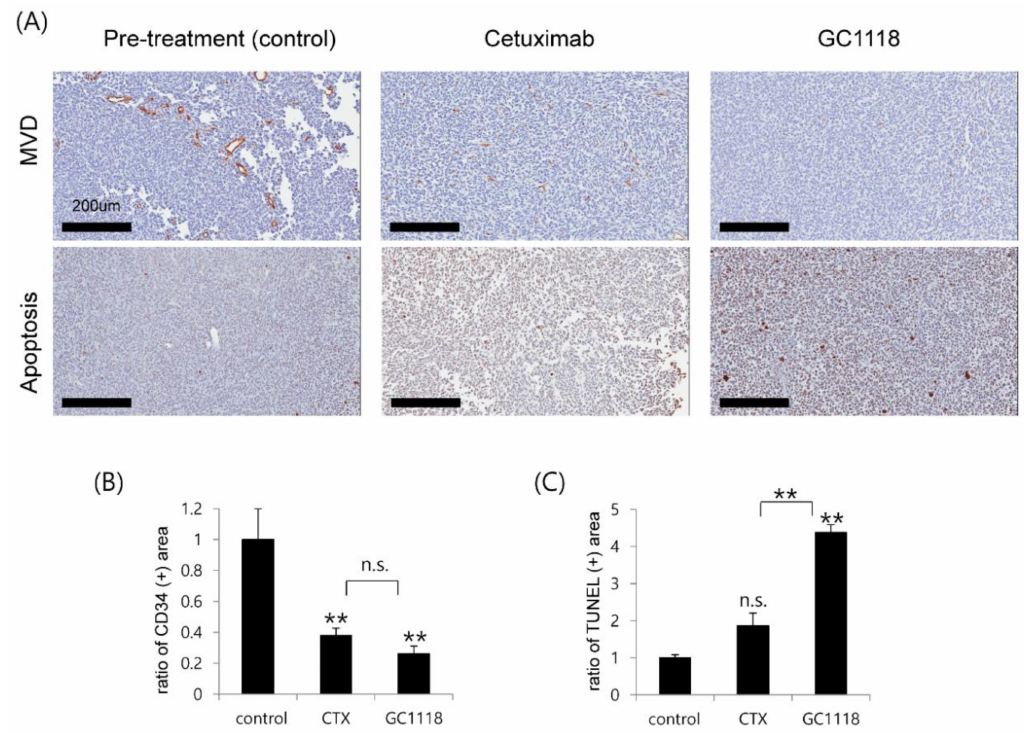
Figure 5. GC1118 exhibited anti-angiogenic e ff ect on GBM tumors and induced apoptosis of GBM tumor cells. ( A ) Representative IHC images of tumor tissue derived from orthotopic PDX models (N626) demonstrated the anti-angiogenic and apoptotic e ff ect of GC1118 treatment. Microvascular density (top row) and apoptosis (bottom row) were assessed using IHC (CD34 for microvascular density (MVD)); terminal deoxynucleotidyl transferase dUTP nick end labeling (TUNEL) for apoptosis on pre- and post-treatment (cetuximab and GC1118) tumor specimen. ( B , C ) Data are shown as the means of at least six experimental replicates ± standard error. p -values were calculated using two-sided Wilcoxon test (non-significant., p > 0.05; **, p ≤